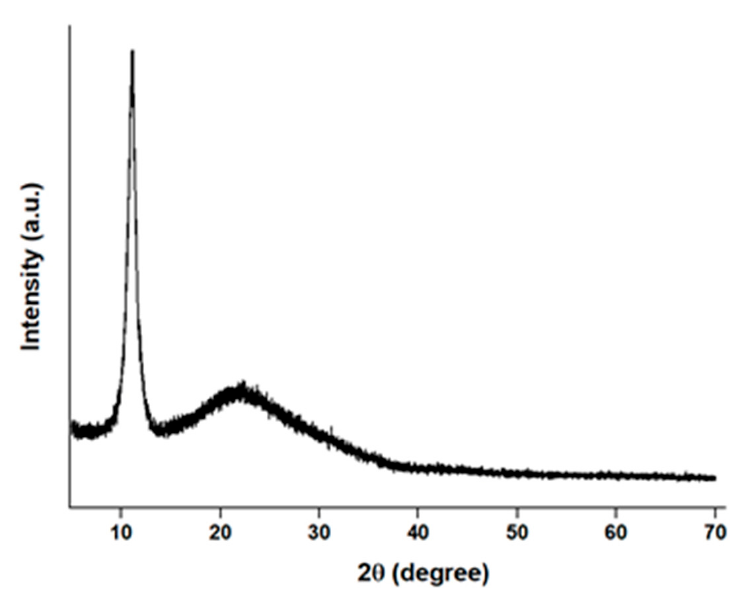
Figure 3. XRD patterns of GO.